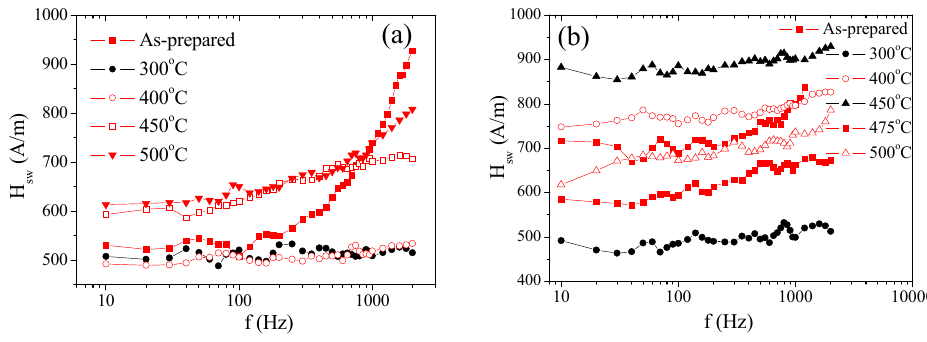
Figure 17. Frequency dependence of the switching field of as-prepared and annealed samples with ρ = 0.41 ( a ) and with ρ = 0.6 ( b ) annealed at various temperatures. Reproduced from reference [70], Figure 4.